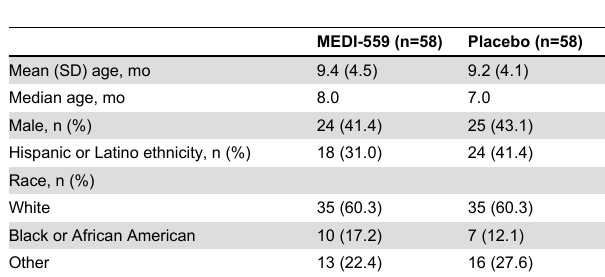
Table 1. Demographics of study subjects.